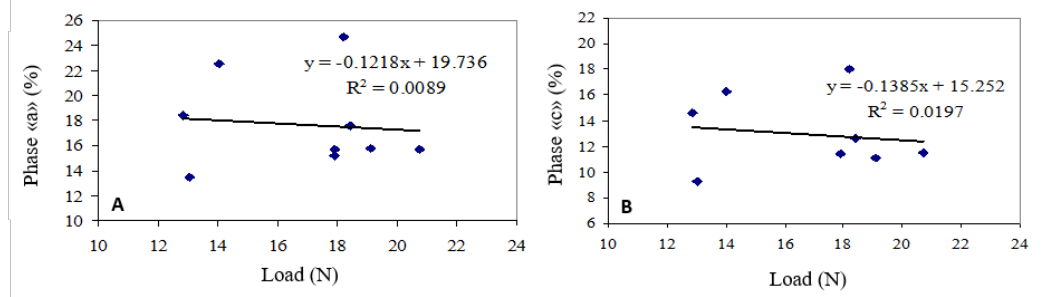
Figure 4. Correlation between the touch point pressure and the length of phase ”a” ( A ) and ”c” ( B ).